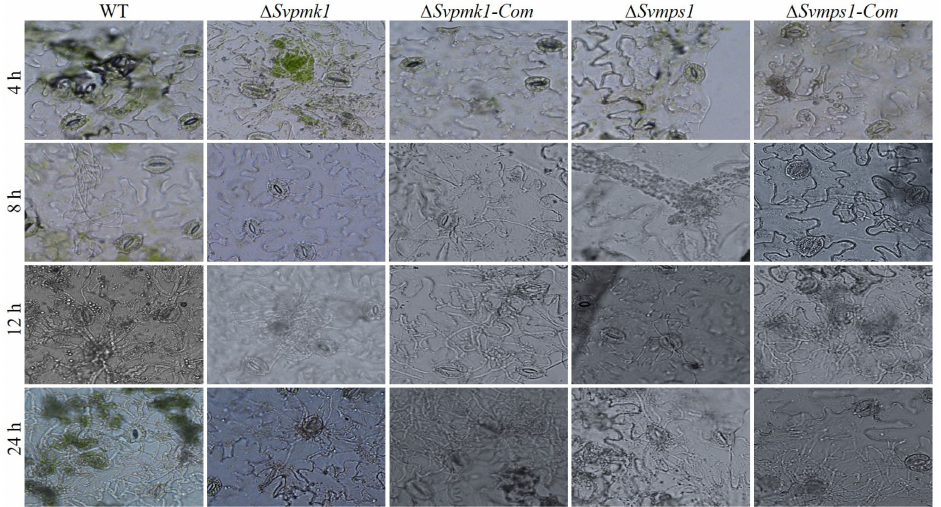
Figure 7. Penetration assay of the WT and the indicated strains of S. versabilis . Mycelial plugs from 5-day-old cultures were inoculated on 3-week-old host leaves. The hyphal growths were observed at 4, 8, 12 and 24 h. Scale bar = 50 µ